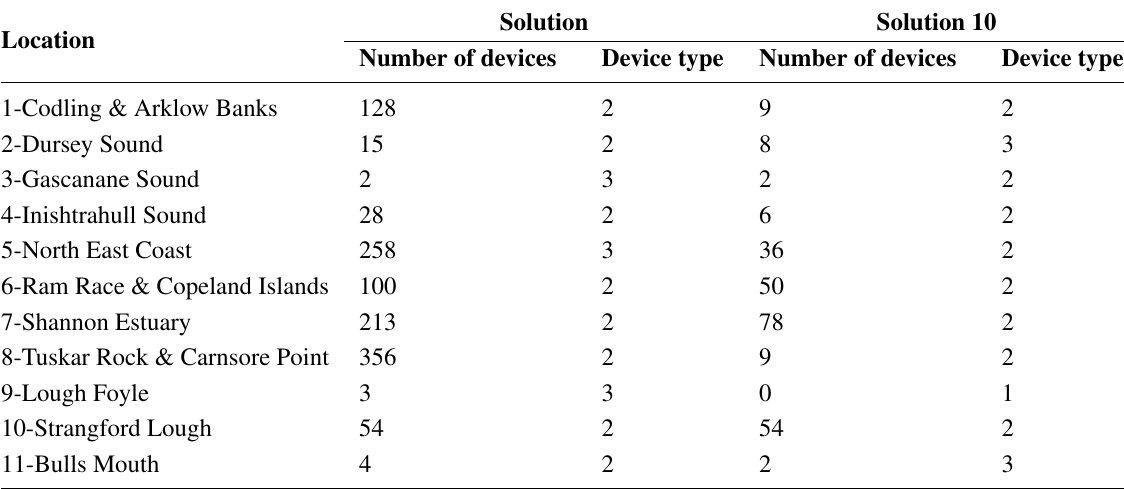
Table 5. Simulation results: POS (number of installed devices and device type) for the solutions 1 and